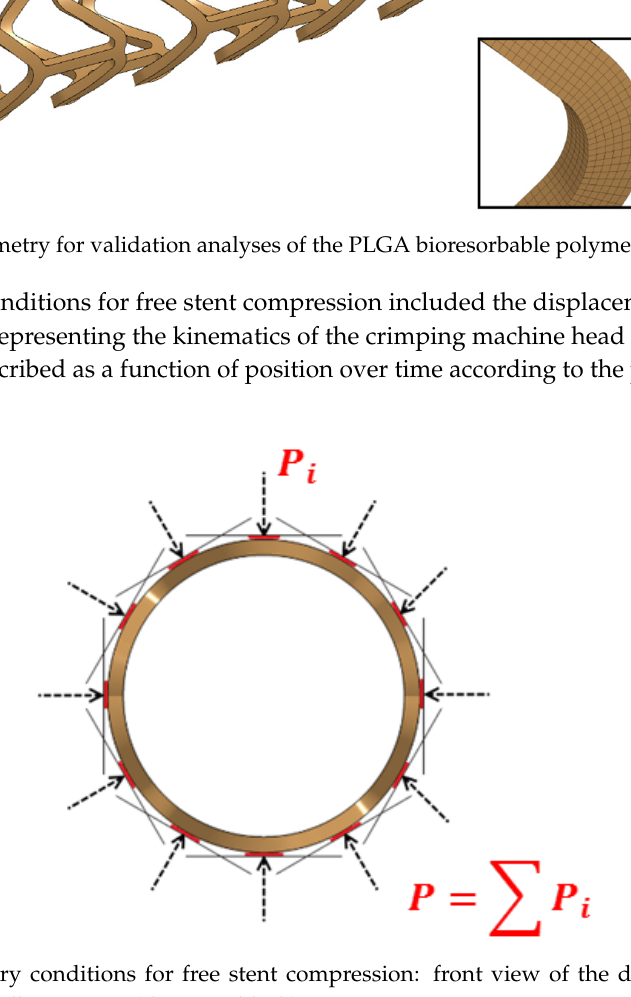
Figure 5. Model geometry for validation analyses of the PLGA bioresorbable polymer constitutive model.